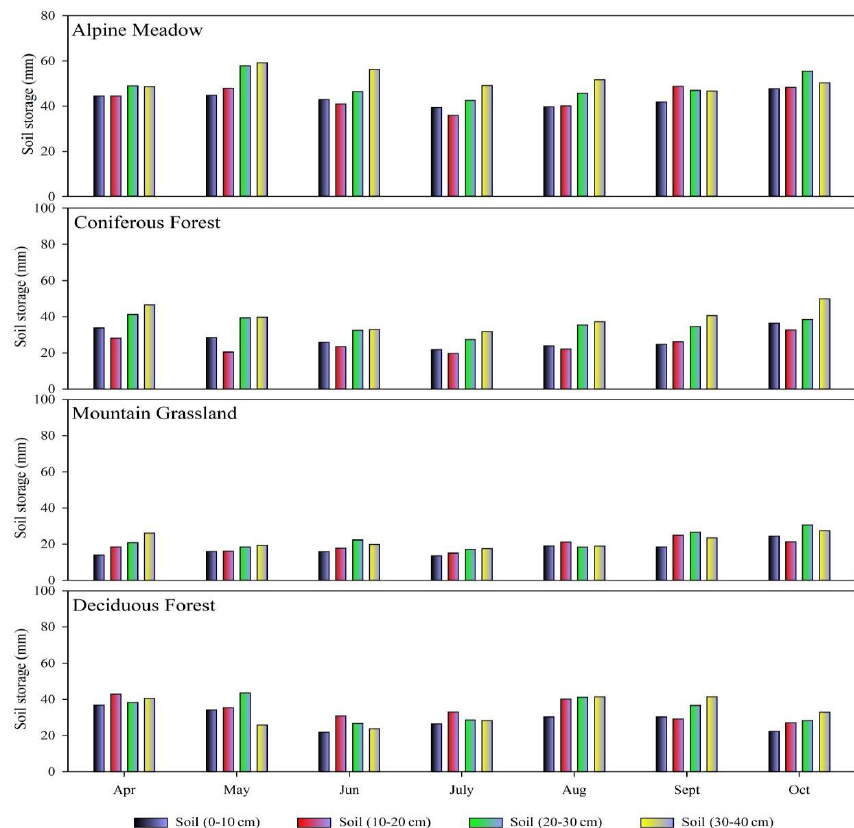
Figure 7. Monthly variation of soil water storage in 0–40cm soil layer of different vegetation